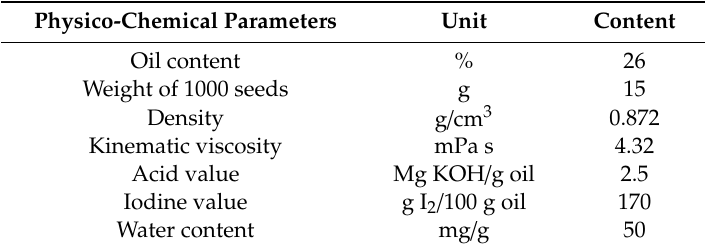
Table 1. Physico-chemical properties of the C. tinctoria seed